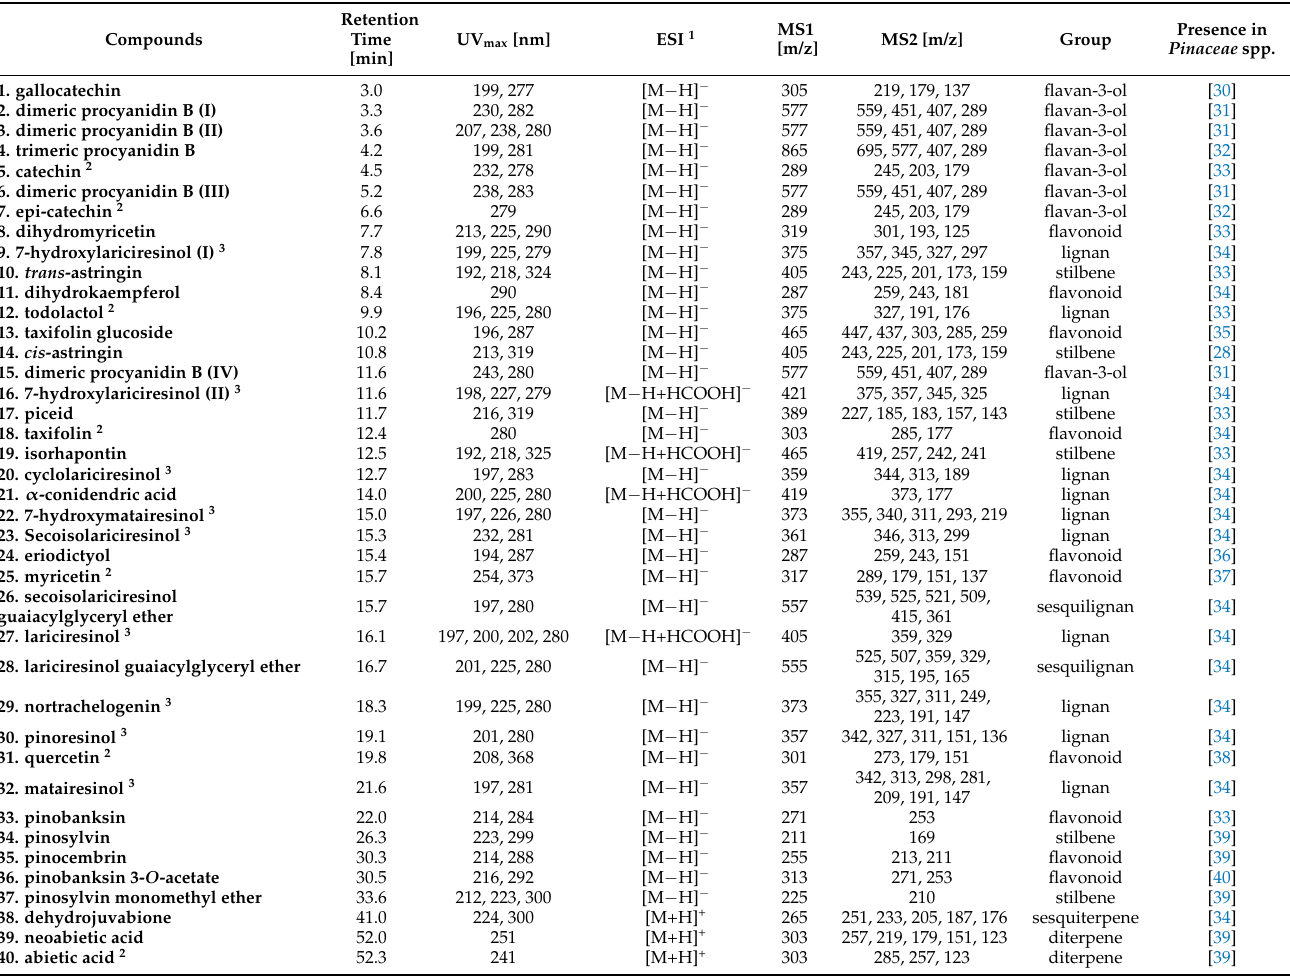
Table 1. Retention time, UV, and ESI-MS/MS data of the compounds identified in Pinaceae species wood using LC-DAD–ESI-MS/MS